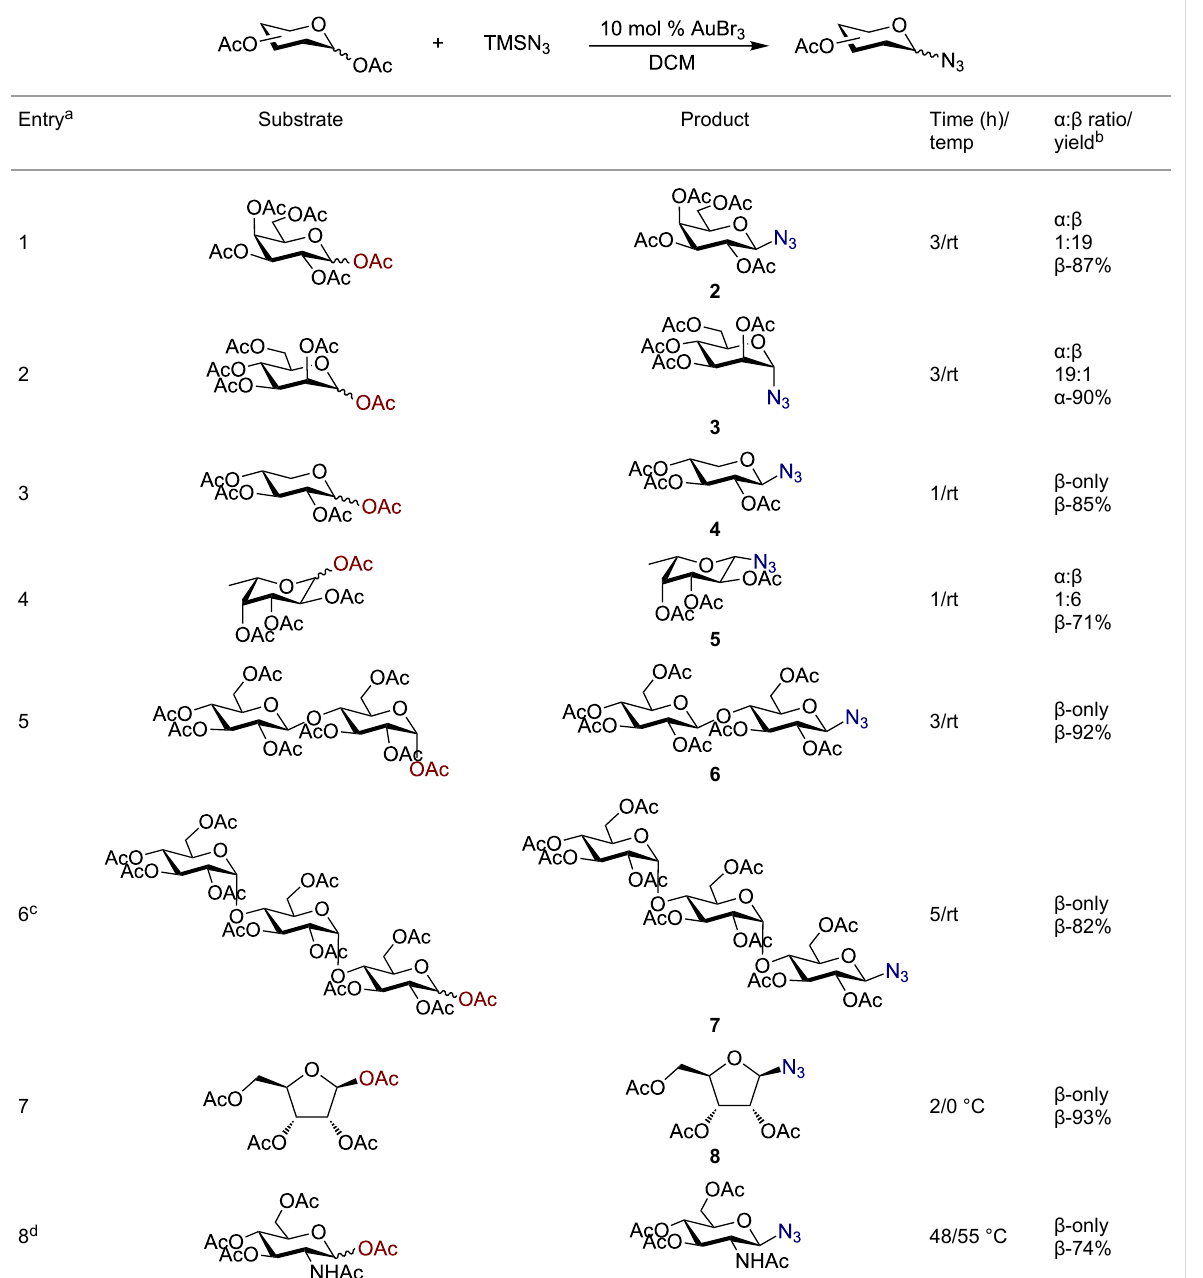
Table 1: Scope of AuBr 3 -catalyzed azido glycosylation of